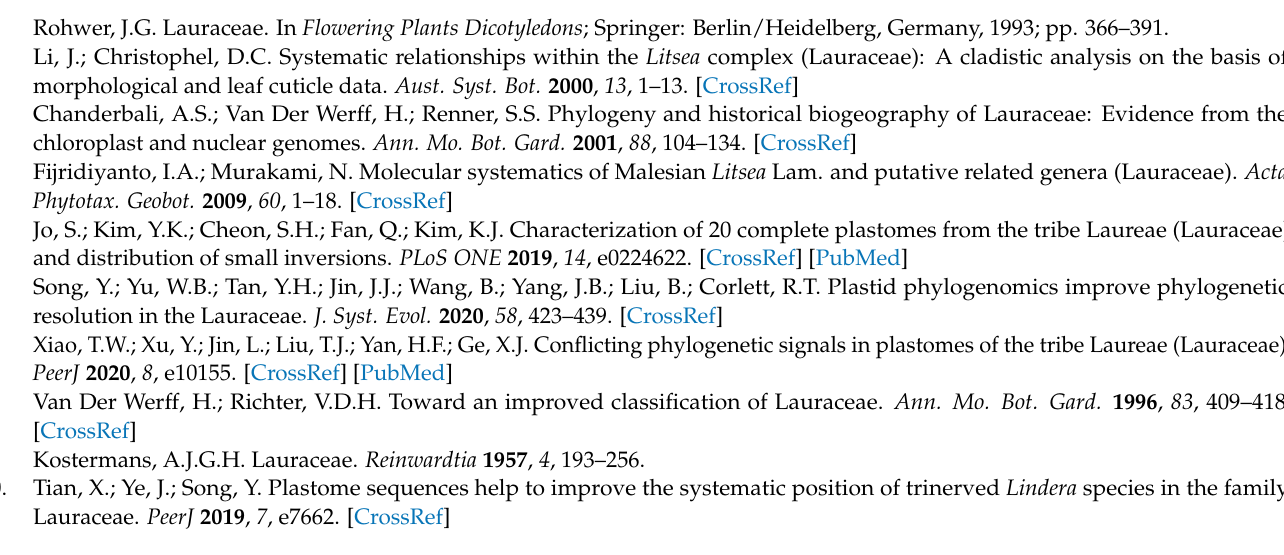
plastome protein-coding sequences; Figure S2: Mauve alignment of Dodecadenia grandiflora and 13 Litsea plastome revealing no interspecific rearrangements; Figure S3: Comparison of Pi values, (a) among D. grandiflora and 13 Litsea plastomes, and (b) among 68 plastomes of the Litsea complex; Table S1: List and accession number of 71 taxa used in this study; Table S2: Relative synonymous codon usage of Dodecadenia grandiflora plastoms; Table S3: RNA editing sites amino acid changes of